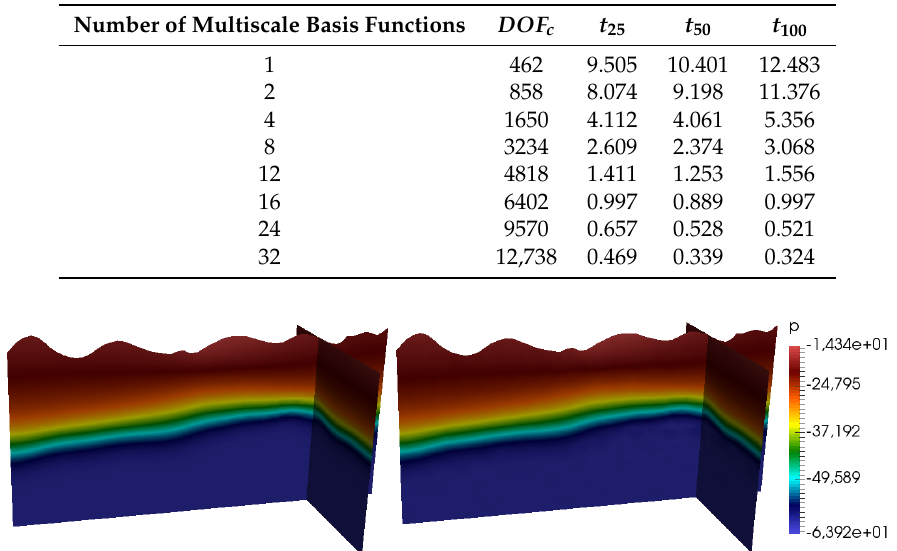
Figure 13. Numerical results for Test 3.DBC . Solutions p and p ms for the final time. Left : Fine-scale solution DOF f = 43,524. Right : Multiscale solution using 32 basis functions DOF c = 12,738. Table 7. Numerical results for Test 3.DBC . Relative L 2 error (%) for different numbers of multiscale basis functions.